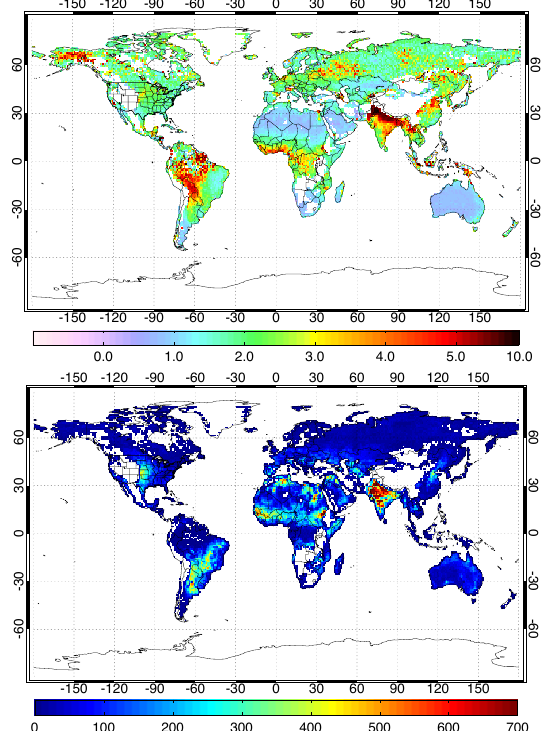
Figure 4. (upper panel) AIRS global NH 3 VMRs at 918hPa, av- eraged from September 2002 through August 2015. The colorbar is linear from 0 to 5ppbv and 5 to 10ppbv, but with different in- crements. (lower panel) The total occurrences (number of days) of high concentrations (VMRs > 1.0ppbv at 918hPa) in the 13-year period. Red/blue colors indicate relatively high/low occurrences of high concentrations, respectively.